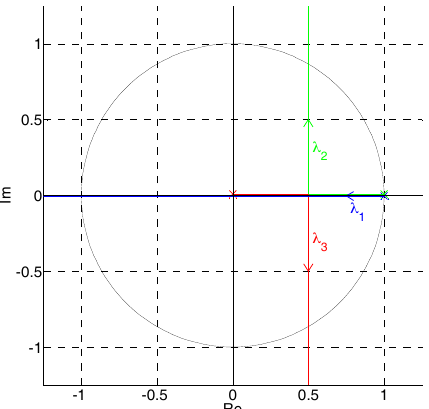
Figure 3. Root-locus chart for the SCM pole λ 1 and observer poles λ 2,3 .